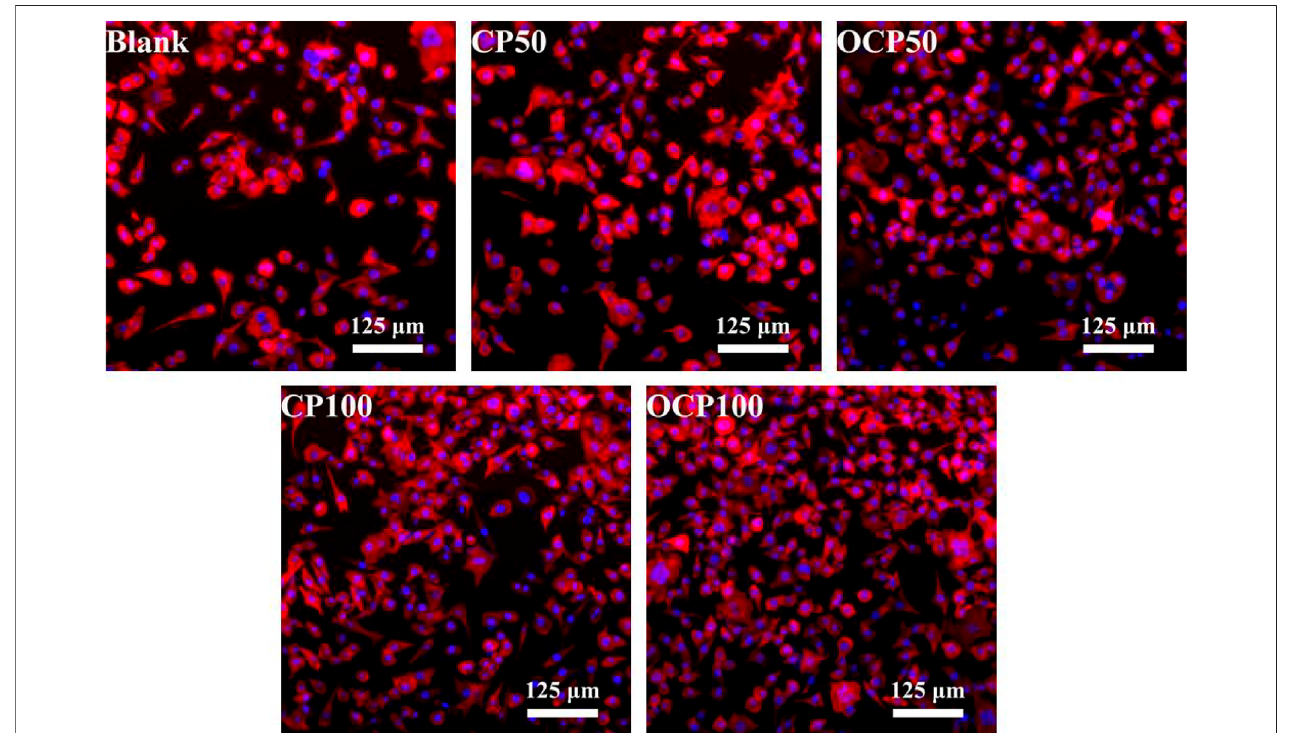
FIGURE 6 | Adhesion morphology of cells after co-culture of hydrogel and cells.